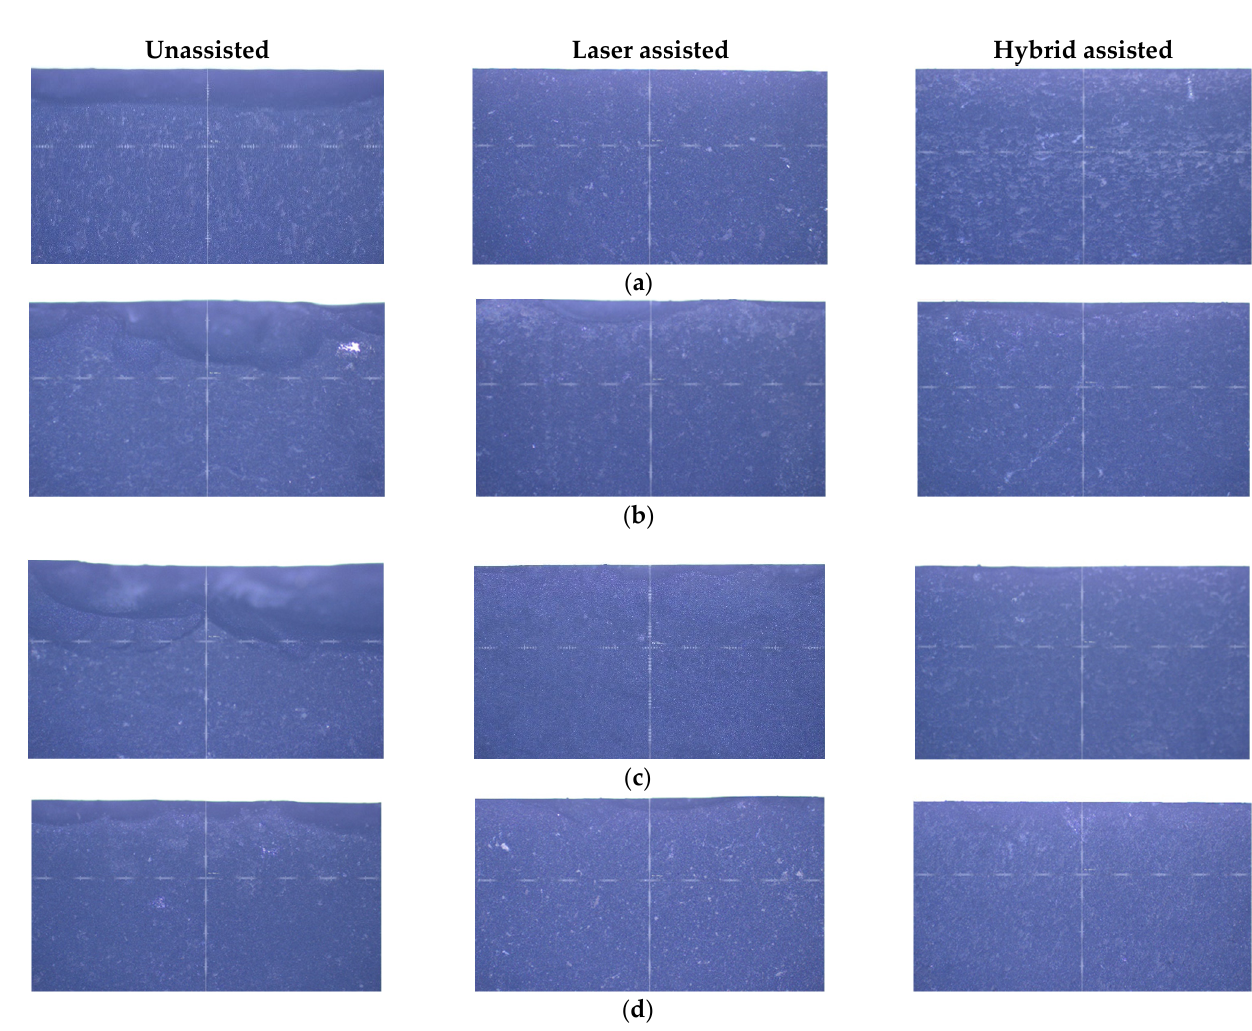
Figure 10. Edge morphology of silicon nitride milling at ( a ) n = 6000 rpm, F = 500 mm/min, and a e = 0.02 mm; ( b ) n = 6000 rpm, F = 1500 mm/min, and a e = 0.10 mm; ( c ) n = 9000 rpm, F = 1000 mm/min, and a e = 0.06 mm; and ( d ) n = 12000 rpm, F = 1000 mm/min, and a e = 0.02 mm.